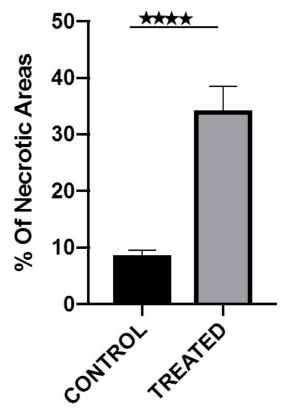
Figure 6. Percentage of the total necrotic areas per tumor. The 4 stars indicate the p value. p <